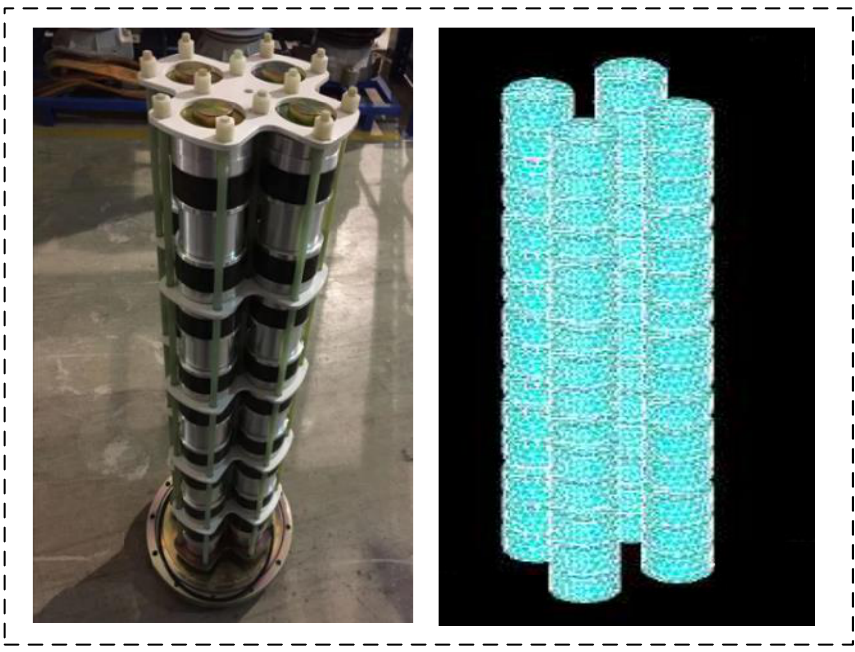
Figure 1. The arrester structure and simulation model of the four-column parallel zinc oxide arrester. Table 1. The material property settings of the four-column parallel zinc oxide arrester material.